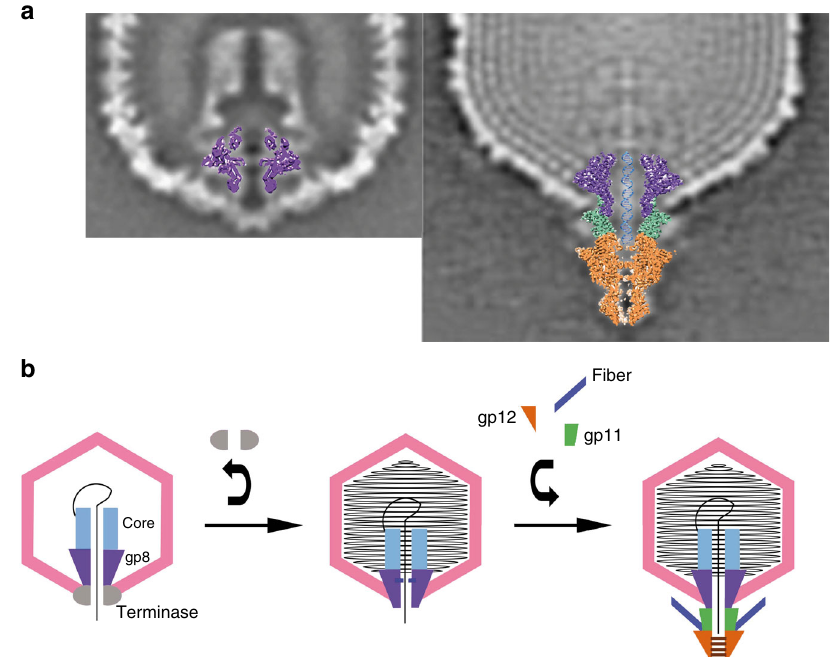
Fig. 6 Proposed model for T7 bacteriophage DNA securing inside the capsid. a Overlapping of the “ free ” portal into the prohead (left) and the tail complex into the mature virus (right) from central sections through the reconstructions described in ref. 40 . b Scheme showing the T7 bacteriophage assembly pathway. The capsid is shown in pink, the portal (gp8) in purple, the core complex in light blue, the terminase in gray, the adaptor (gp11) in green, the nozzle (gp12) in orange, the fi bers in dark blue, and the DNA in black. The portal channel valve can be either open or closed. When the portal is in the prohead, the terminase – portal interaction stabilizes the open conformation, allowing DNA packaging. When the terminase leaves the complex, the portal channel valve closes, thus preventing DNA leakage from the capsid. The interaction of the portal with the adaptor protein re-establishes the open conformation of the portal channel valve, permitting the DNA to slip along the tail channel up to the nozzle, ready for ejection. In the mature virus, the gates of the nozzle protein close, retaining the DNA in the tail channel. These gates are closed until the reorganization of the nozzle (untwisting), which is triggered by the interaction of the tip and the fi bers with the host membrane. The gates then open and the viral genome is